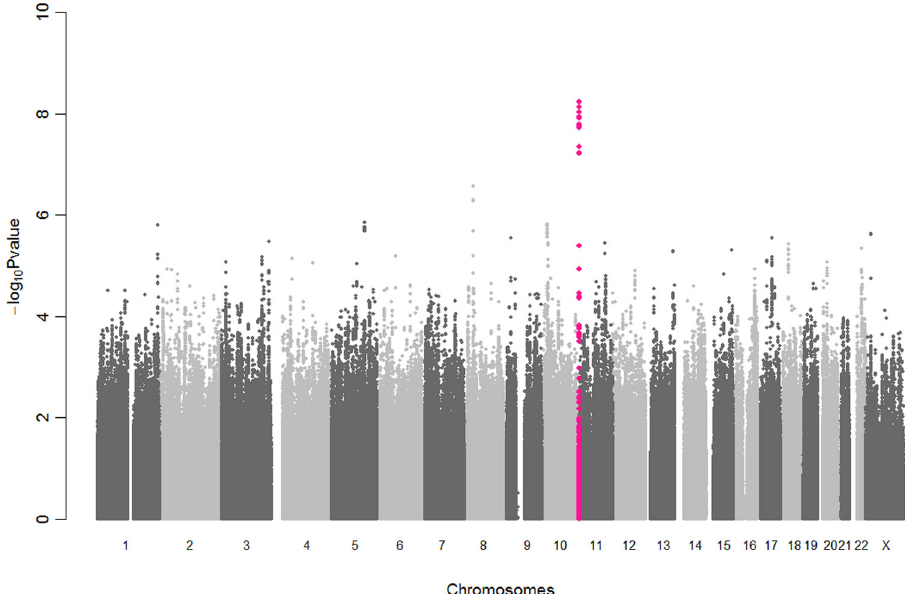
Fig. 1 Manhattan plot of the meta-analysis of sex-strati fi ed GWAS. Associations of the meta-analysis of sex-strati fi ed GWASs. Y -axis, P -value on a − log10 scale. X -axis, chromosomal position based on NCBI build 37. Variants near the newly identi fi ed BET1L locus are highlighted in pink.